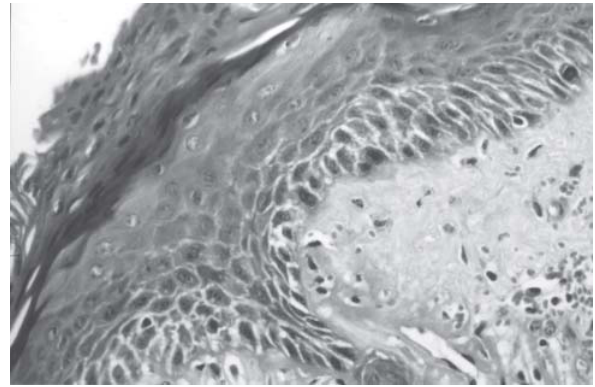
FIGURE 4- Microscopic section of a specimen in Group IV presenting extensive area of hyperkeratinization, loss of normal epithelial stratification, loss of polarity and disorganization of the basal layer, nuclear pleomorphism and increased number of